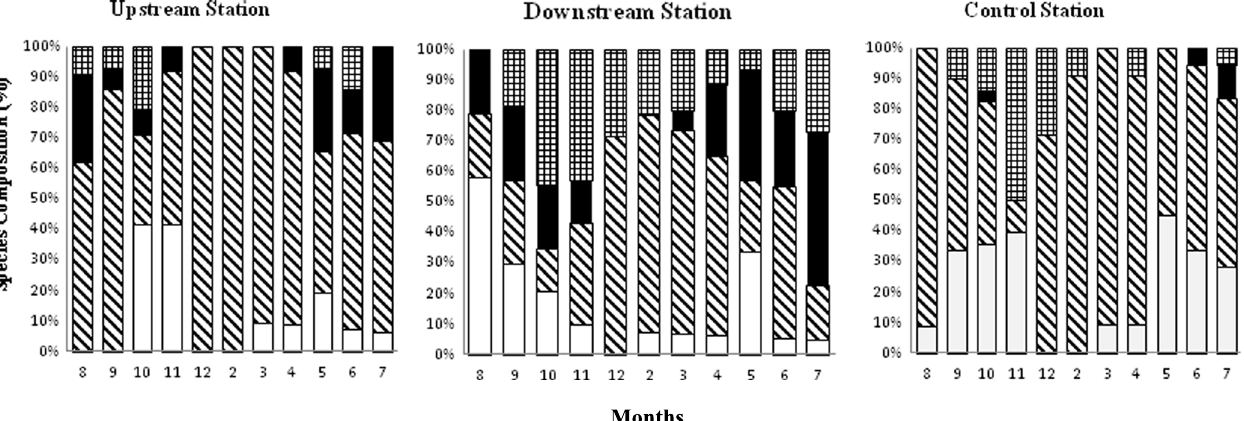
Fig. 2. Monthly species composition at three sampling stations on Kocabas Stream near a fi sh farm (White: S. cf. macrostigma , Striped: P. phoxinus , Black: B. oligolepis , Squared : S. cii ).